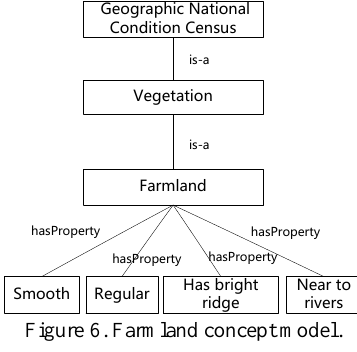
Figure 6. Farmland concept model.